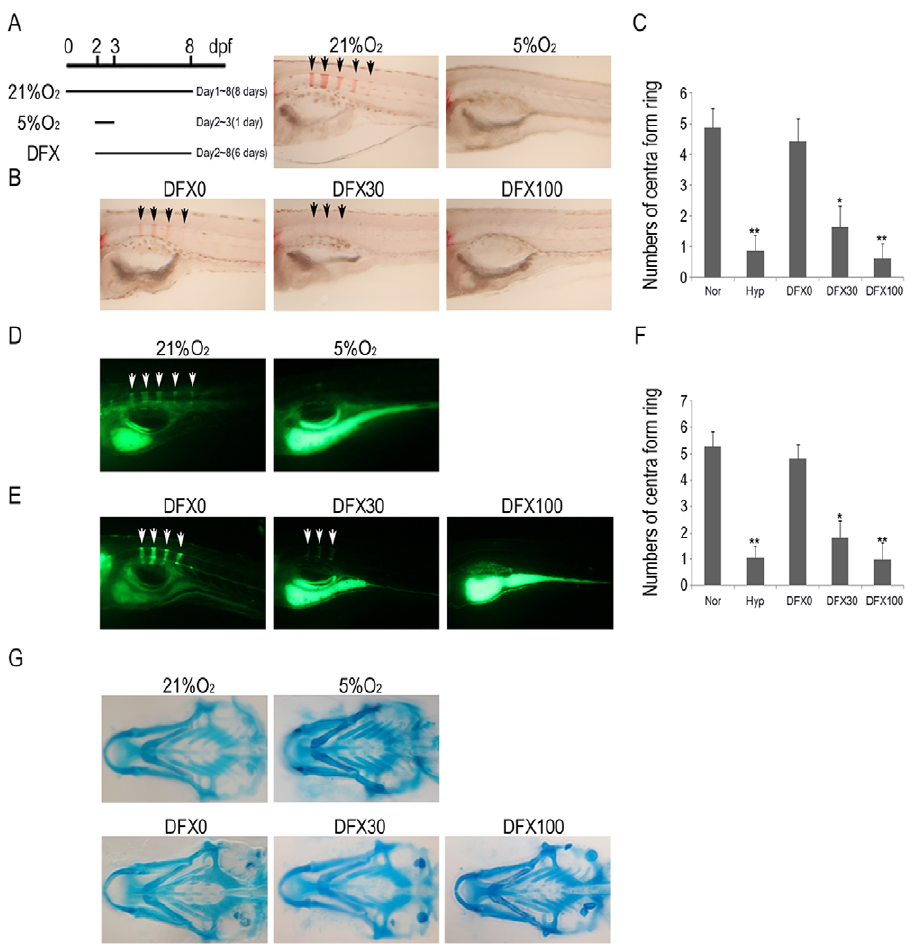
Figure 1. Hypoxia inhibits mineralization but not chondrogenesis in zebrafish. A , D, G Zebrafish at 2 days post-fertilization (dpf) were treated with 5% O 2 for 1 day or B , E, H indicated concentration of DFX for 6 days and stained with ( A, B ) ARS, ( D, E ) calcein labeling, or ( G, H ) Alcian blue staining at 8 dpf. Mineralization was indicated by positive ARS staining or calcein labeling in the spine area (arrow) and the number of positive staining developing centra form ring with ARS or calcein labeling were calculated (C, F).